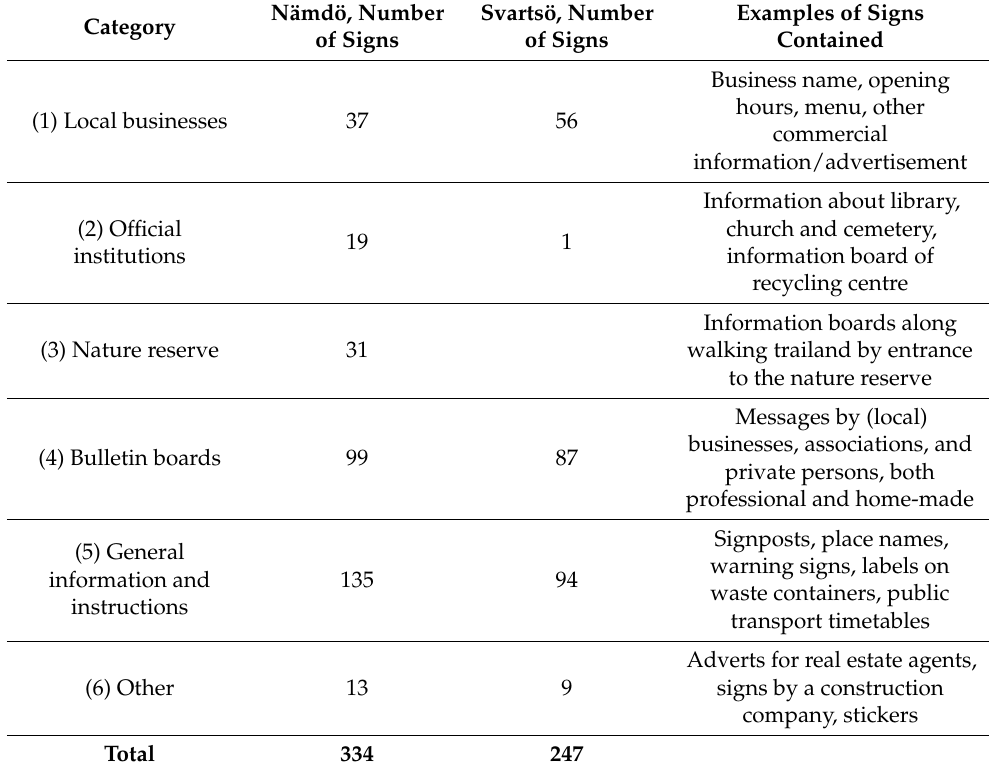
Table 1. Signs of the linguistic landscapes categorized by location and function. Categories 1–4 correspond to different types of text assemblage points while categories 5–6 include items found throughout the linguistic landscapes.